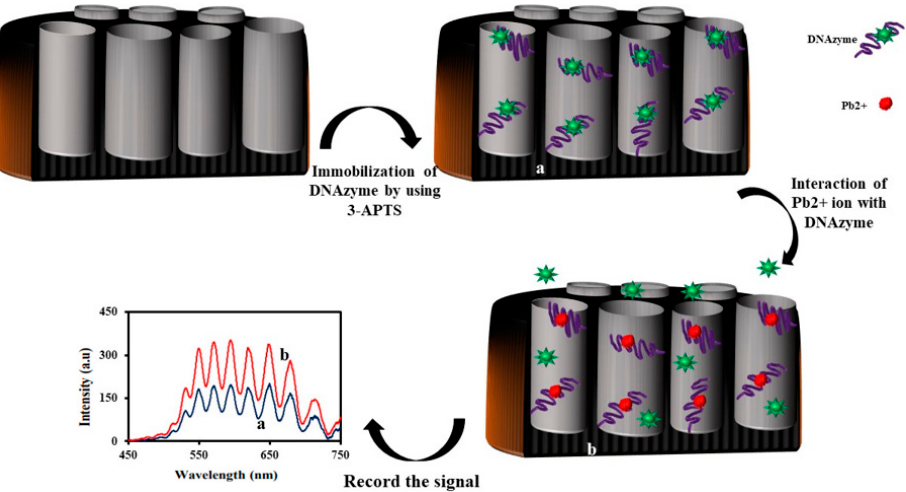
Figure 9. Schematic illustration of the NAA-DNAzyme sensor for the determination of Pb 2 + ions using IRS.